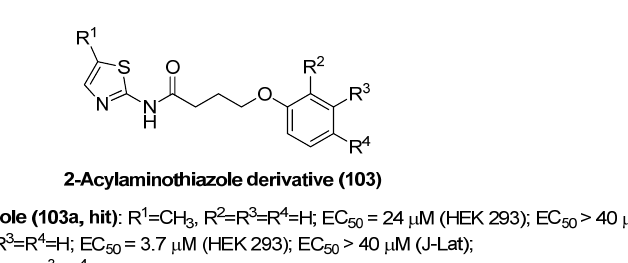
Figure 23. Chemical structures of 2-acylaminothiazole derivatives 103a–c.